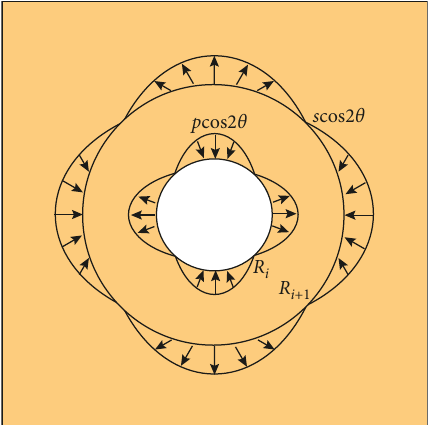
Figure 9: Stress induced by deviator stress. Outer stress, s cos2 θ ; interface pressure, p cos2 θ